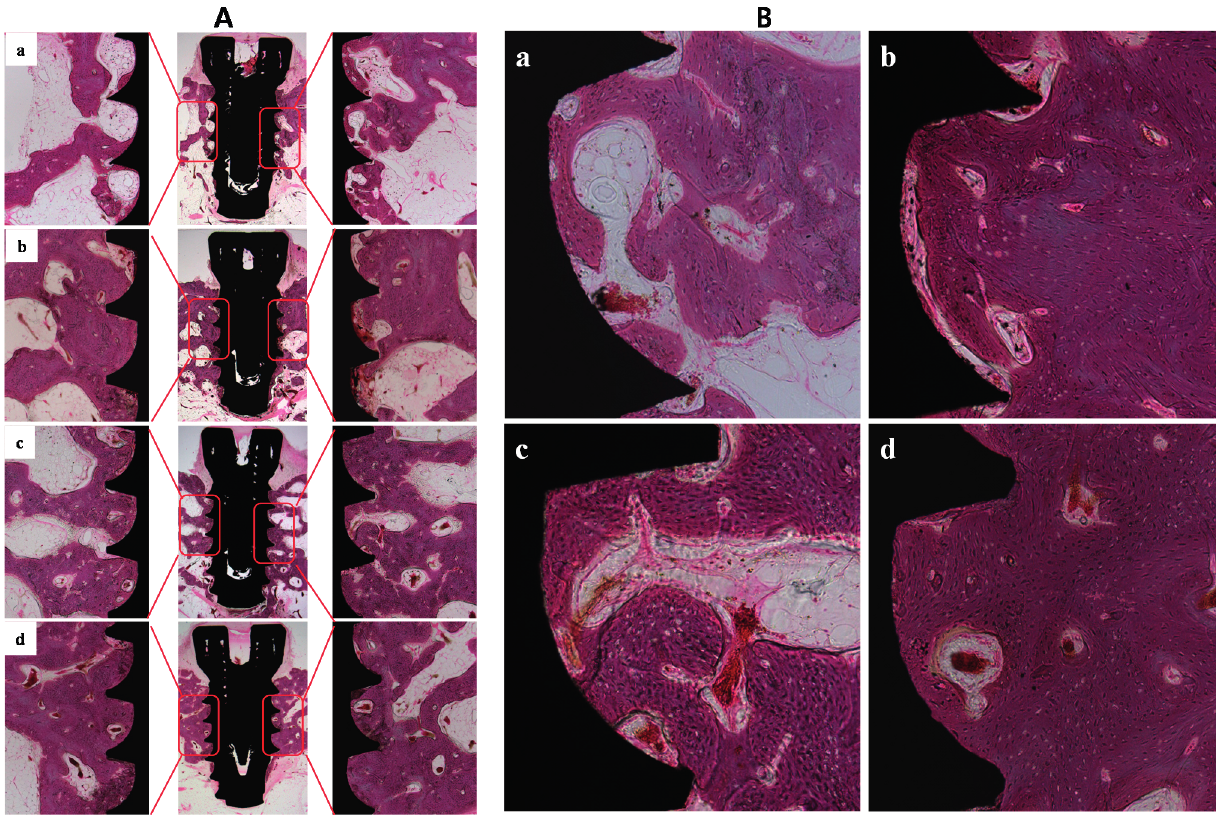
Figure 4. ( A ) Histological evaluations of ( a ) Control; ( b ) SLA; ( c ) ANO; and ( d ) Modi-ANO. (Magnification: Central, ×12.5; Right and Left, ×40); ( B ) Histological images of ( a ) Control; ( b ) SLA; ( c ) ANO; and ( d ) Modi-ANO (Original magnification